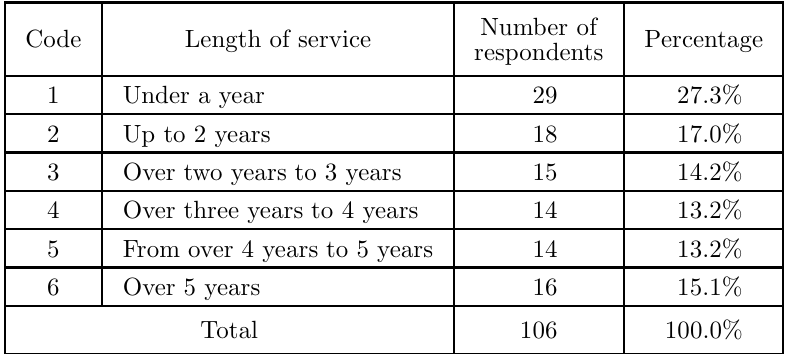
Table 1. Helpline workers’ length of